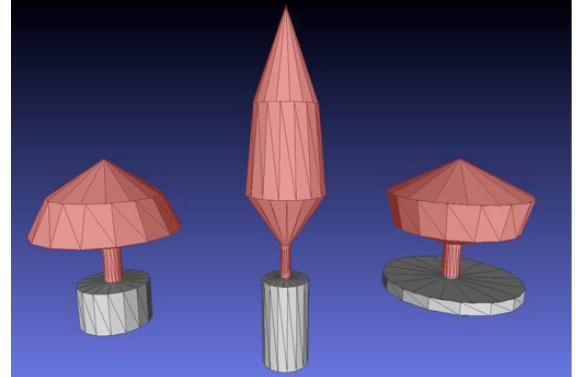
Figure 9: From Left to right, Heart-shaped root, Taproot and Surface-root examples are presented as LOD 1 in gray. A cylinder warping the horizontal influence area of the root is presented for each type of tree root. Hypothetical tree crowns and trunks in red are presented above each root as an example. LOD 2: Tree roots have 3D geometries similar to its characteristic shape, introducing a visually appealing representation compared to LOD 1 simple cylinders but with the similar growth potential representation. Visually, having distinctive shapes serves as a guide towards differentiating roots and conflicts while keeping root parameters like depth and extension. Analytically, results should be comparable to LOD 1.